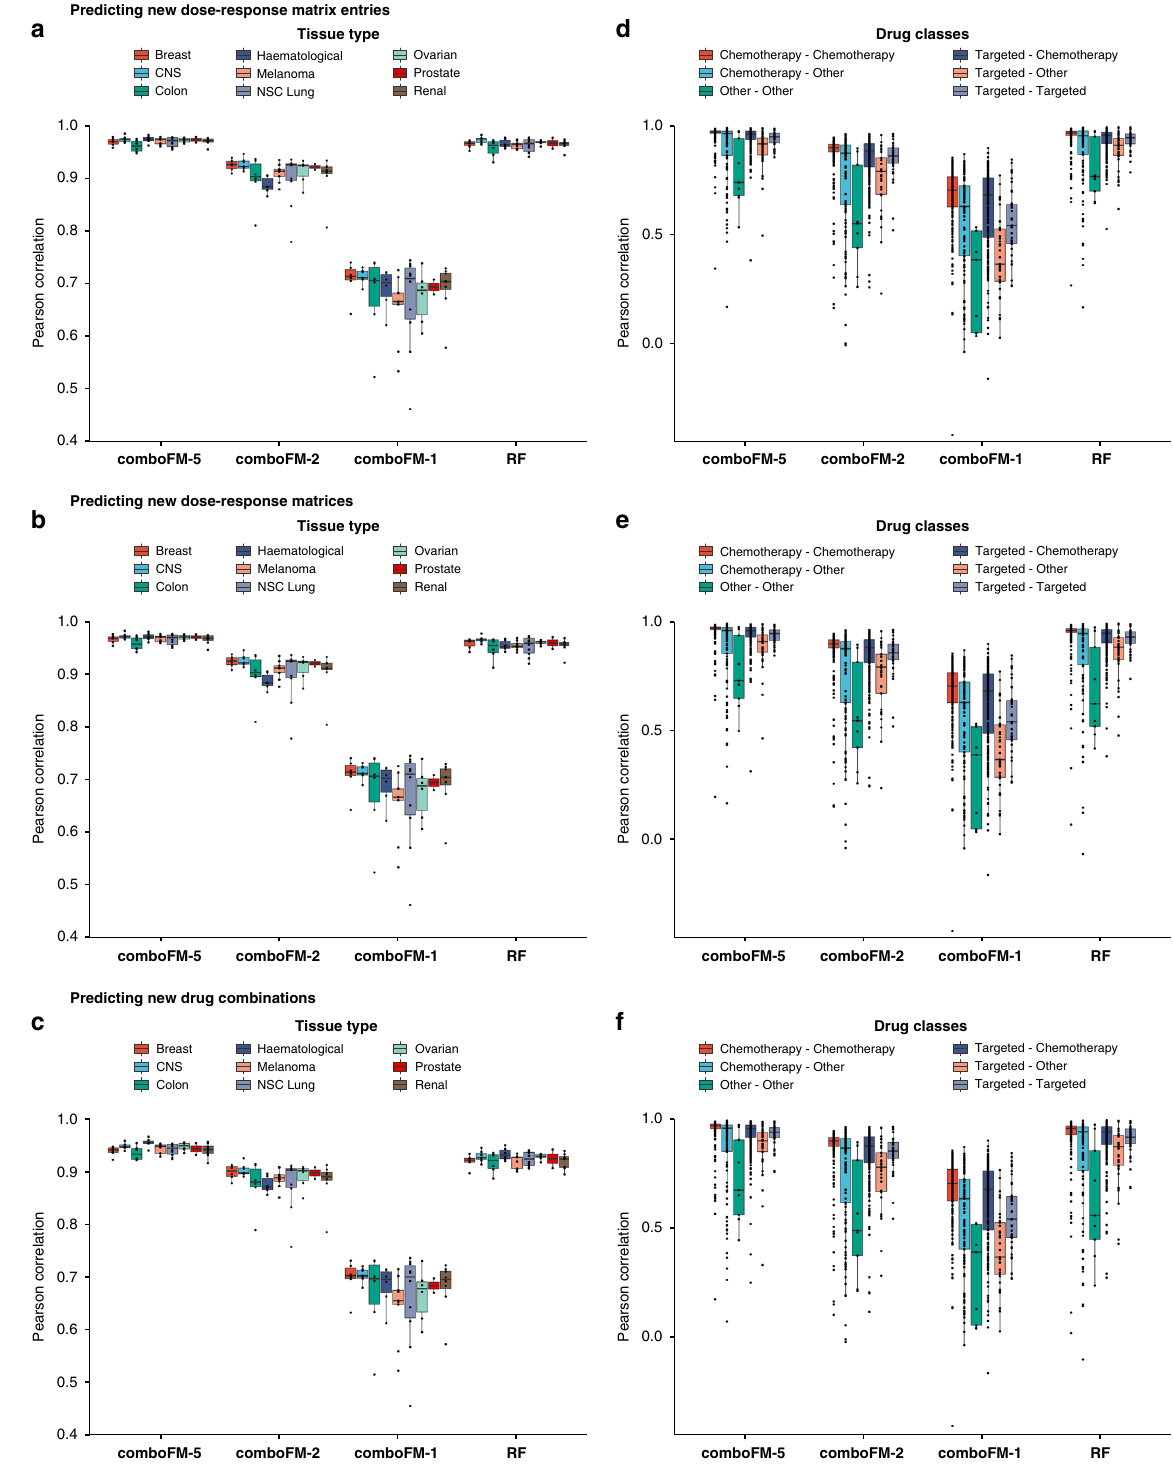
Fig. 3 Predictive performance of 5th (comboFM-5), 2nd (comboFM-2) and 1st order comboFM (comboFM-1), and random forest (RF) across tissue types and drug classes in the three prediction scenarios. a – c tissue types. d – f drug classes. The three prediction scenarios are depicted as follows: a , d predicting new dose – response matrix entries, b , e predicting new dose – response matrices, and c , f predicting new drug combinations. Further information on the drug classes can be found in Supplementary Table 3. In the boxplots, the horizontal lines drawn in the middle denote the median, and the lower and upper hinges correspond to the 25th and 75th percentiles, respectively. The upper and lower whiskers denote the largest and smallest values, respectively, no further than 1.5 times the inter-quartile range (IQR). The points that are not included between the whiskers are outlier